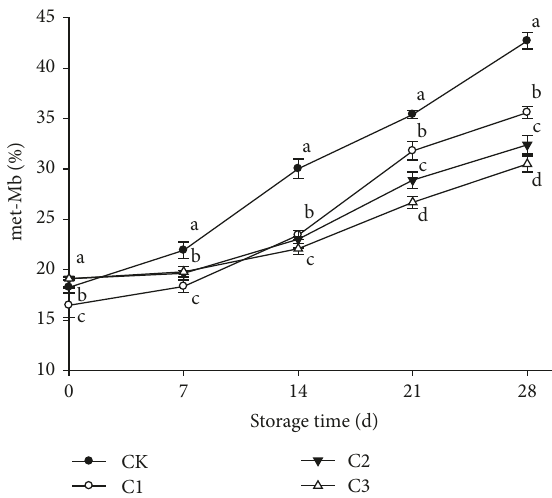
Figure 4: Changes in TVB-N values of beefsteaks with different treatments during storage. CK, the group of beefsteaks without pretreatments; C1, the group of beefsteaks pretreated with 100% CO for 1.5 h; C2, group of beefsteaks pretreated with 100% CO for 1.5 h and soaked in 50mg/L ClO 2 ; C3, group of beefsteaks pretreated with 100%CO for 1.5h and soaked in 50 mg/LClO 2 for 10min and sprayed with 30g/L lactic acid. Data were represented with mean values ± Standard Error; sometimes the bars were too small to see. Different letters mean significant difference of samples with different treatments on the same storage days ( 𝑃 < 0.05 ). Three separate steaks of each treatment were measured; three repetitions were performed for each treatment. 𝑛 = 9 .